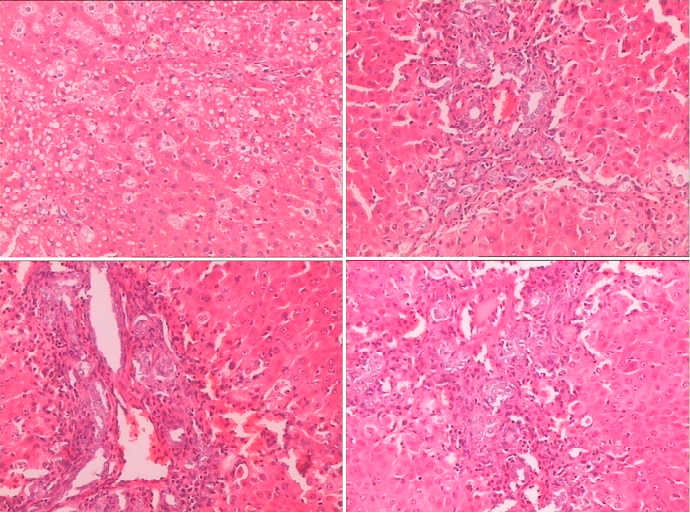
Figure 3. HE-stained histological sections of rat liver in the GE group (Magnification: ×400).